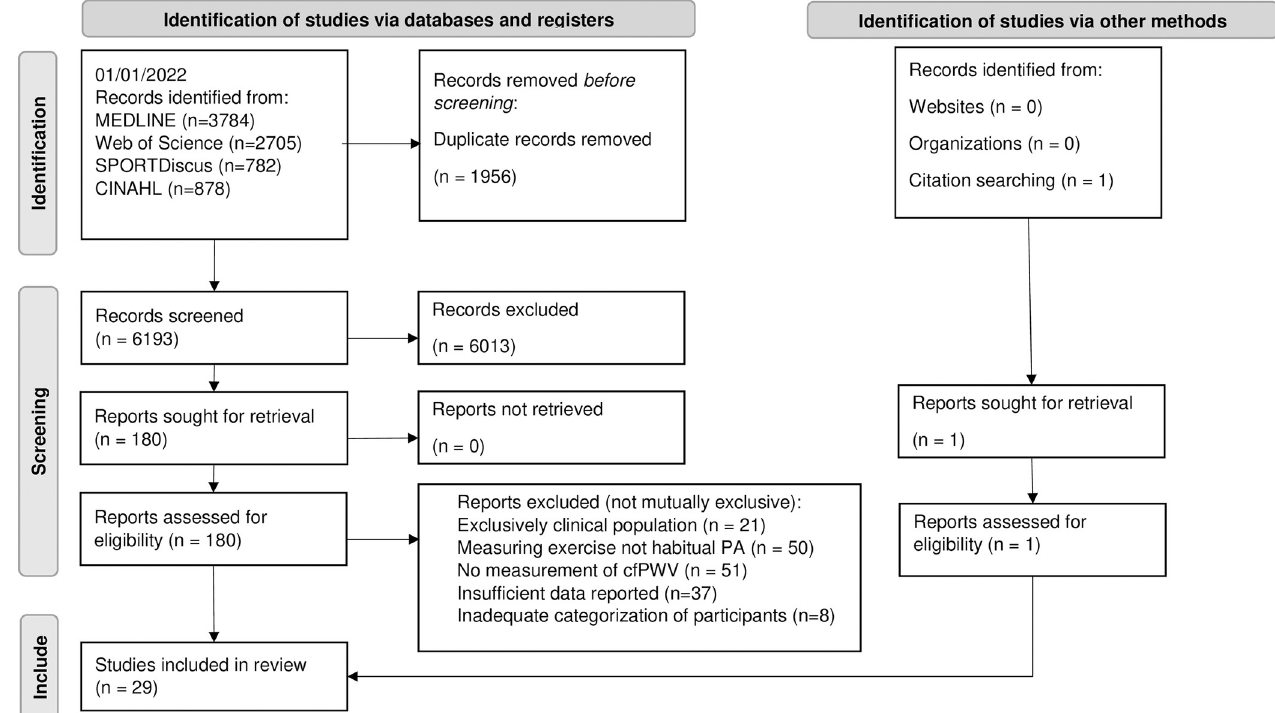
Fig 1. Preferred reporting items for systematic reviews and meta-analyses (PRISMA) flow diagram of search process. cfPWV, carotid femoral Pulse Wave Velocity. PA, Physical activity.